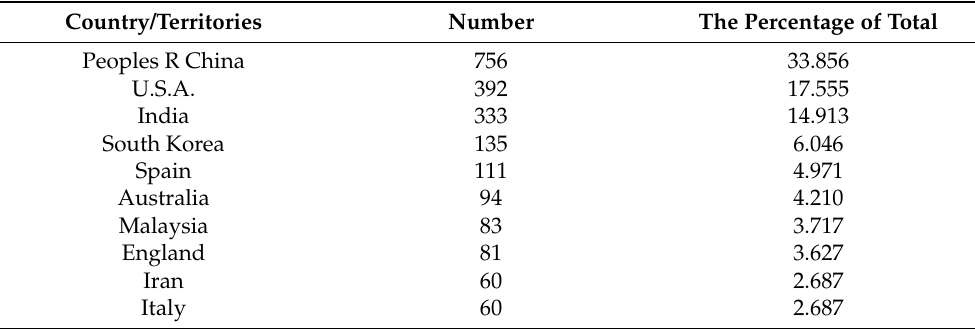
Table 3. The top 10 most productive countries on MFCs in wastewater